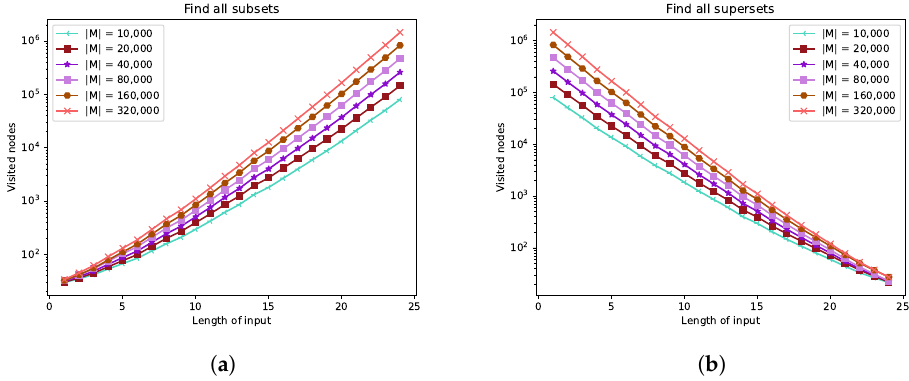
Figure 5. Exhaustive functions of Experiment 1. ( a ) getAllSubmsets; ( b )